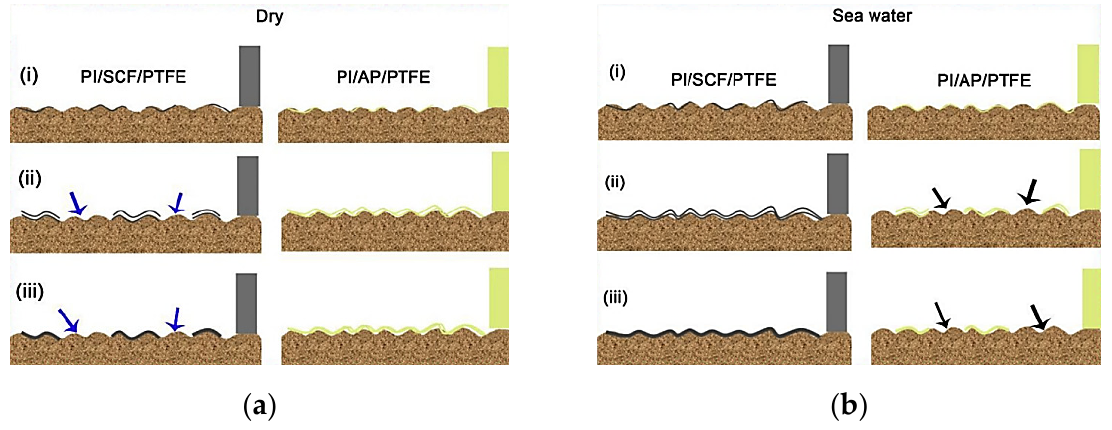
Figure 18. A schematic diagram of TF formation upon sliding of the ‘PI + SCF + PTFE’ and ‘PI + AP + PTFE’ composites on the copper counterpart surface under DSF ( a ) and SWL ( b ) conditions. The transfer process of PI composites to Cu surface consists of three steps: (i) initial transfer of wear debris, (ii) accumulation and removal of wear debris and (iii) compaction of wear debris. Figure is reproduced with permission from reference [149].